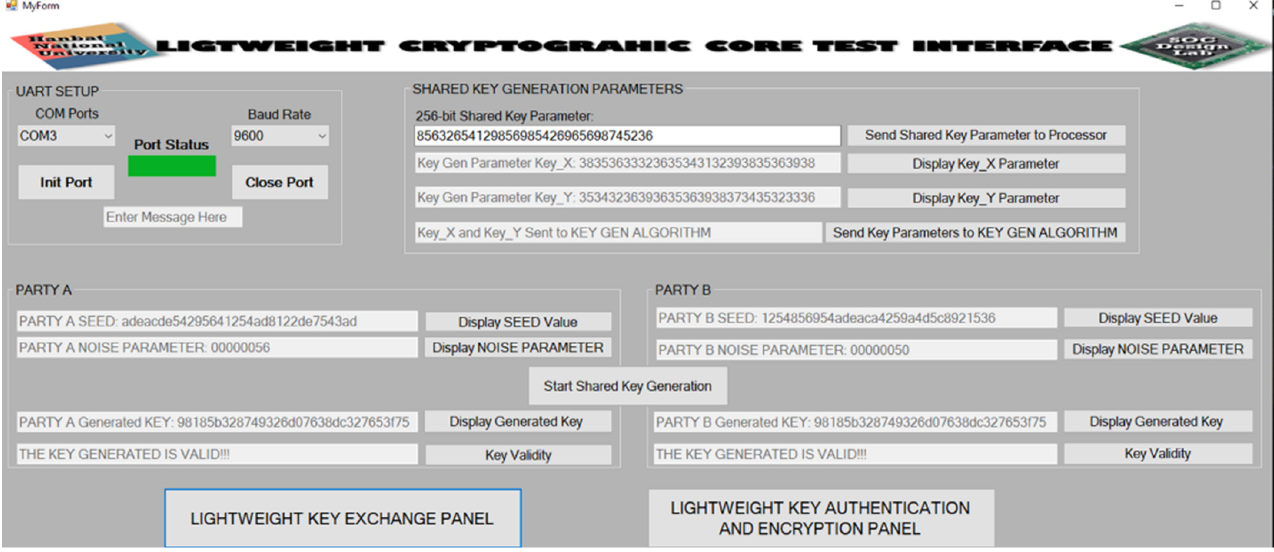
Figure 22. GUI of lightweight key exchange panel.